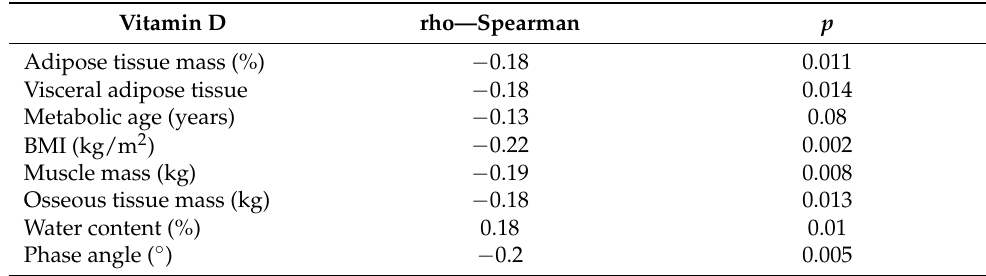
Table 10. Correlation between vitamin D level and body composition parameters in studied